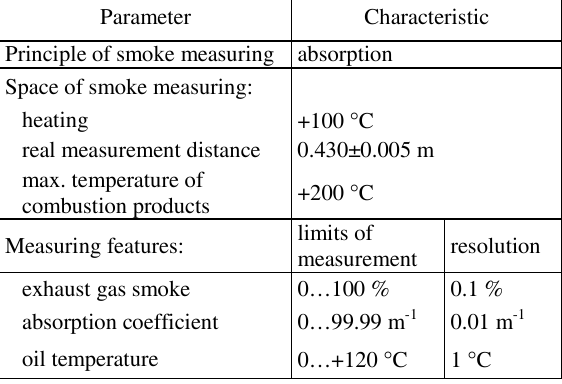
Fig 1 indicates that operation of the 1Z engine with diesel fuel and turpentine blend at rotational speed of 1 700 min –1 with different loadings increases fuel con- sumption B and specific fuel consumption b approxi- e e mately by 2 % only in the vicinity of low loadings. At higher loadings consumption of the fuel blend practi- cally does not differ from the case of pure diesel fuel.